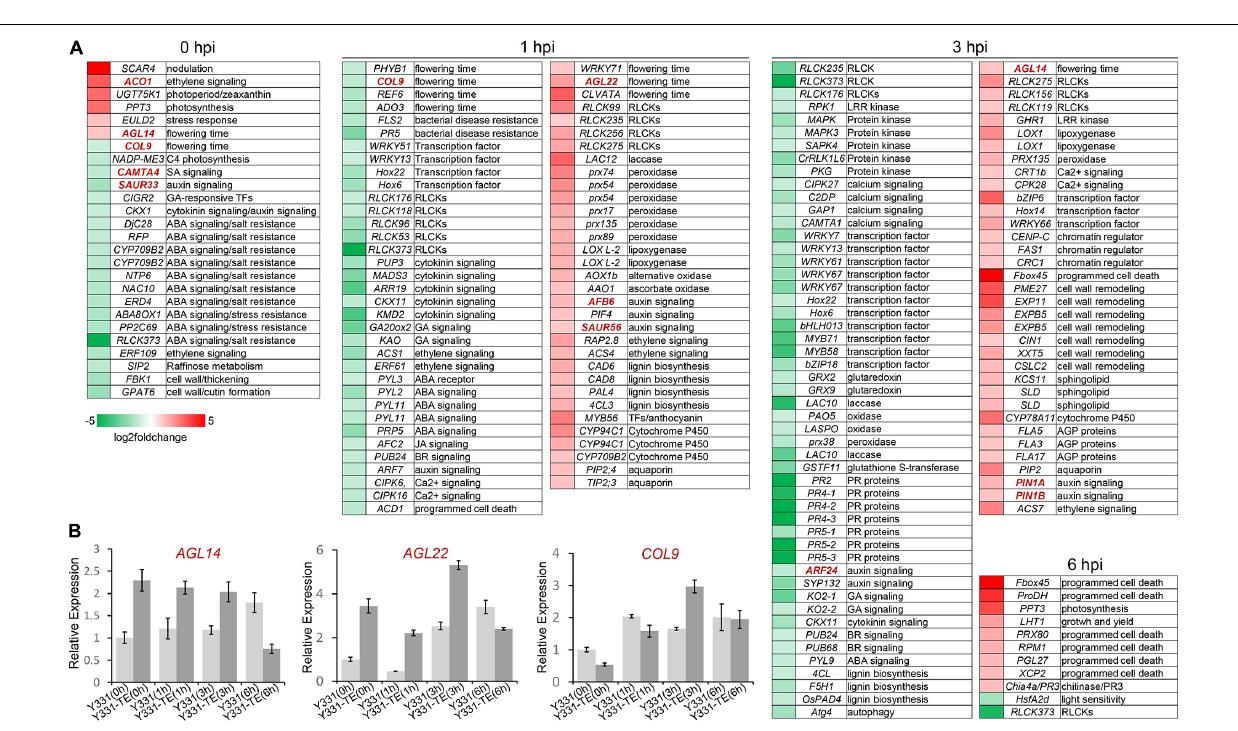
FIGURE 4 | Mapping of differentially expressed genes in maize during different infection stages of Fusarium graminearum. (A) The heatmaps showed detailed relative expression (log2 fold change) of selected genes related to important functions from RNA-seq. Genes were named according to their Arabidopsis or rice orthologs. (B) Relative expression of several putative flowering time-related genes in F. graminearum -infected maize seedling root at different time points. The β -actin gene ZmActin was used as an internal control for normalization. For each gene, the relative enrichment value in Y331-infected seedling root cells at 0 hpi was assigned as 1. Error bars present the ± s.d. of three biological